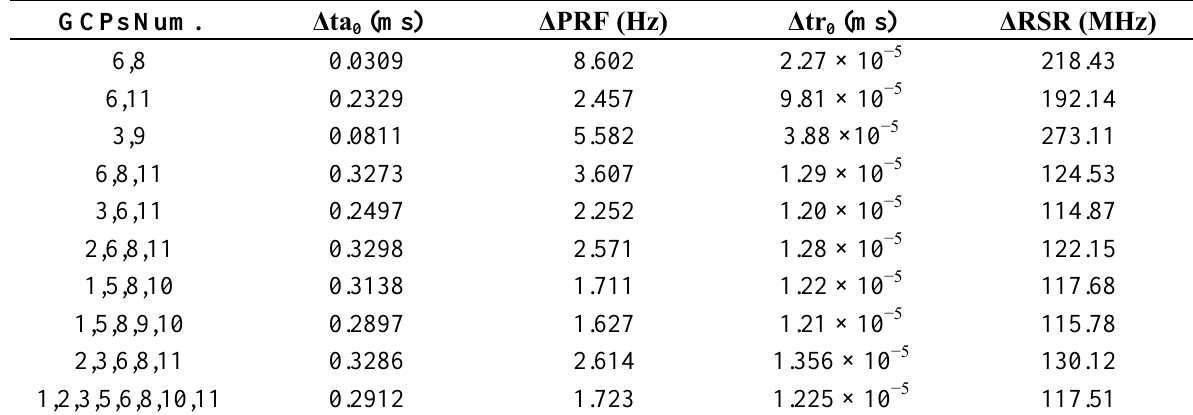
Table 2. Changes in physical sensor parameters for different ground control points (GCP) scenarios. The locations of points listed in column 1 are shown in Figure 2. Δta time for the first line, PRF: pulse repetition frequency, Δtr range sampling